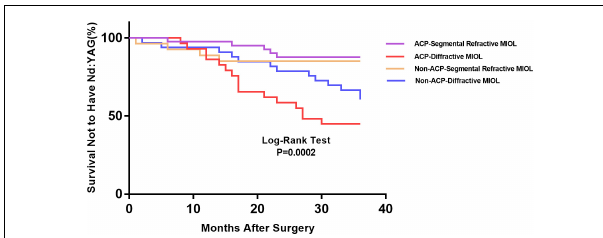
FIGURE 5 | Kaplan–Meier survival plots for eyes by different surgical treatments about diffractive MIOL (AT LISA tri 839MP) (Nd:YAG, neodymium:YAG laser capsulotomy; ACP, anterior capsule